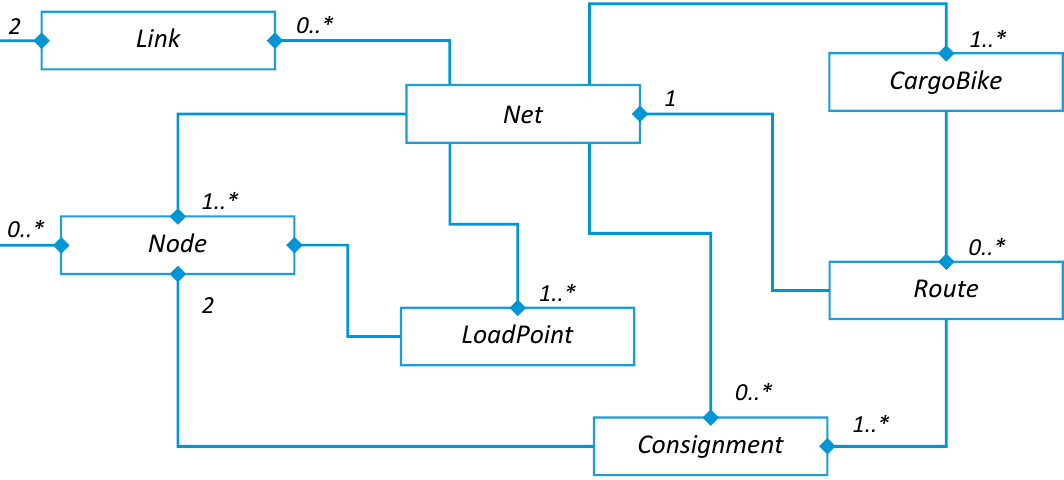
Figure 1. UML-diagram of the library for modeling of goods delivery by cargo bicycles.